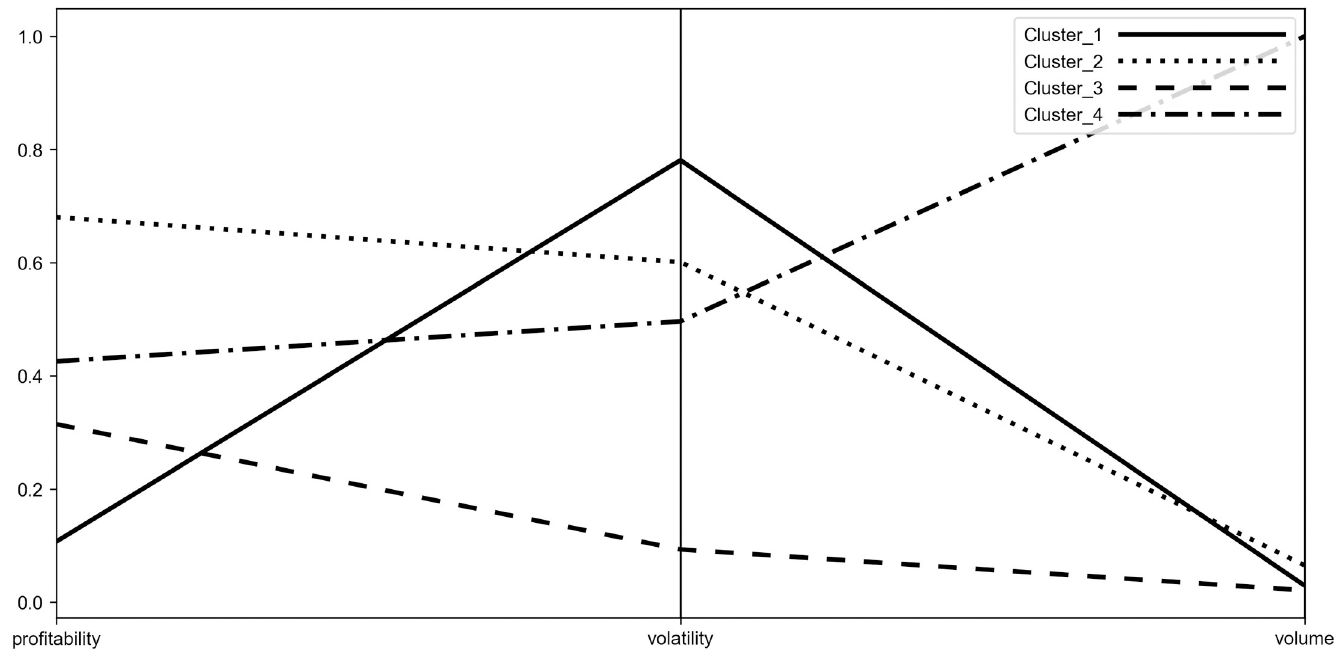
Fig 6. Parallel coordinate plot for